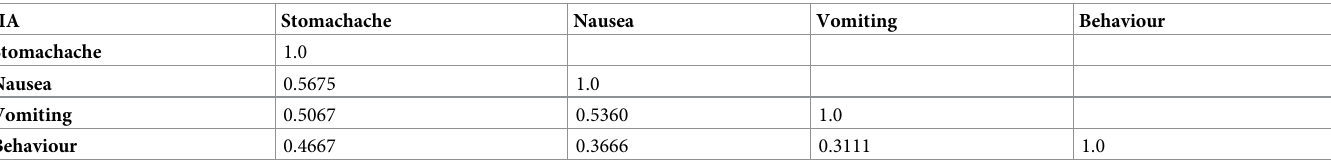
The results of the inter-domain correlations of the four domains of the methotrexate intolerance severity score (MISS) for the juvenile idiopathic arthritis group (JIA) group (n = 120). All correlations are Spearman’s